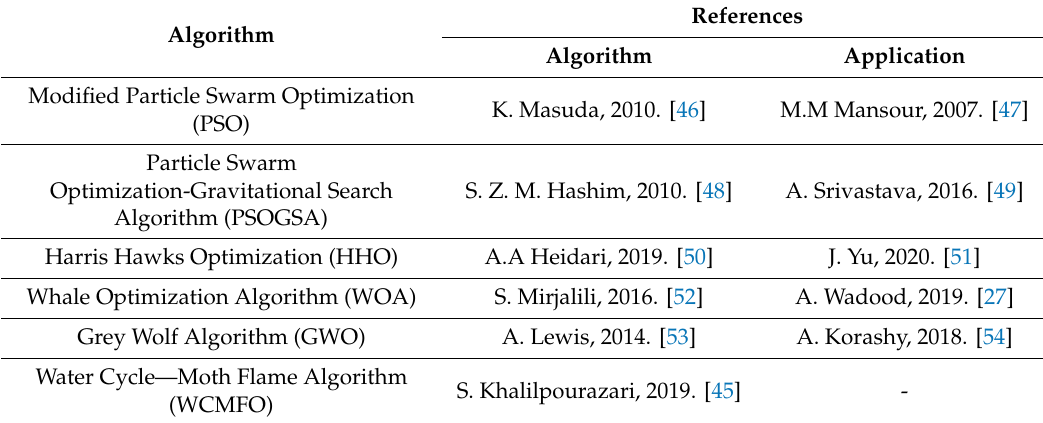
Table 12. Optimization algorithms used for comparison.